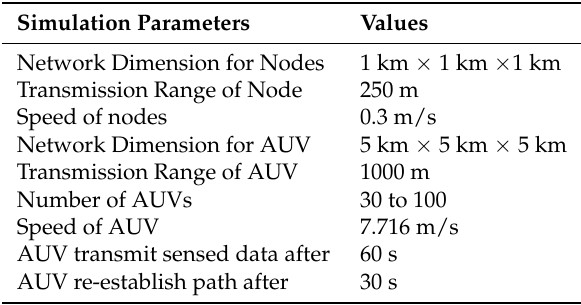
Table 2. Simulation Parameters.